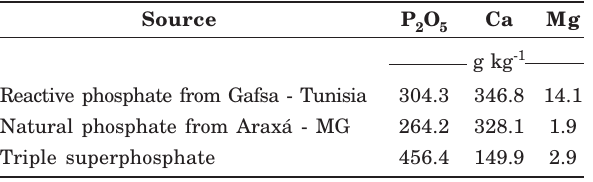
(1) Nitric-perchloric